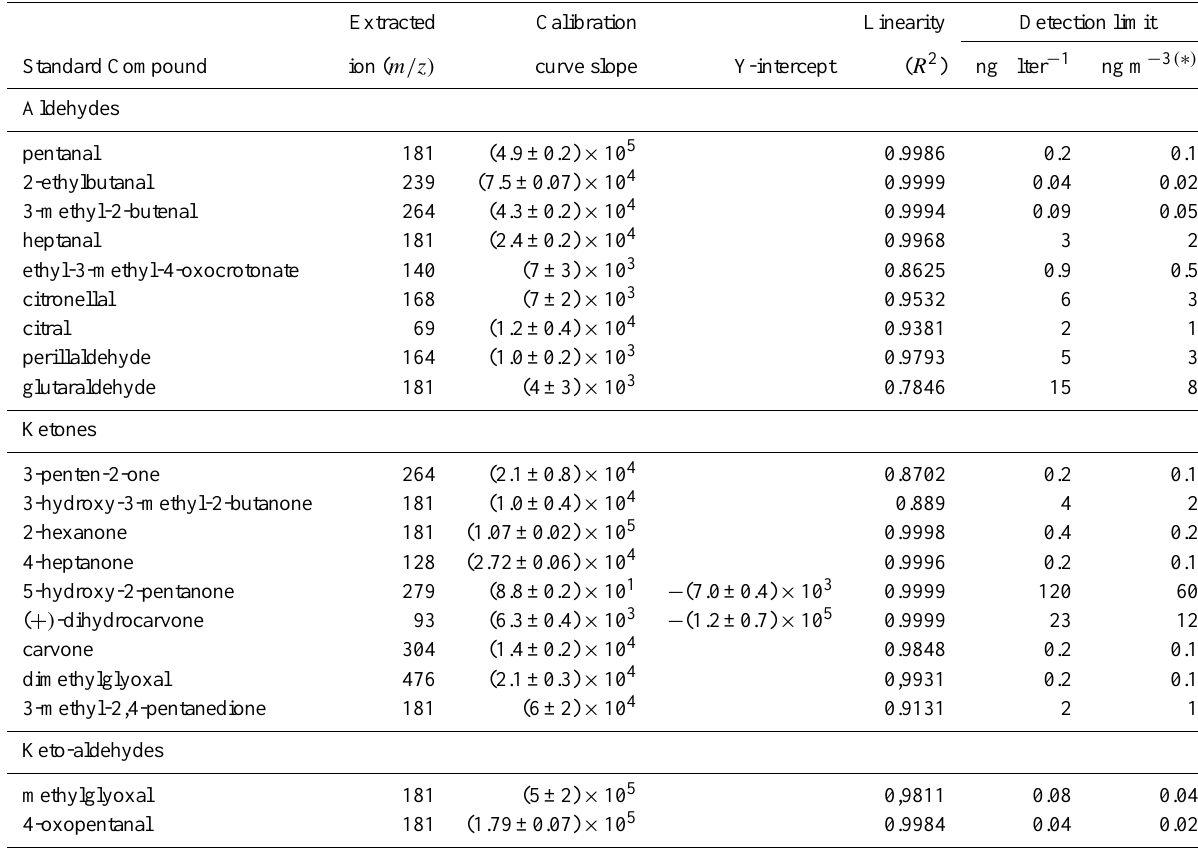
Table 4. Calibration curves slopes, linearities and detection limits for particulate carbonyl compounds trapped on quartz fibres filters and